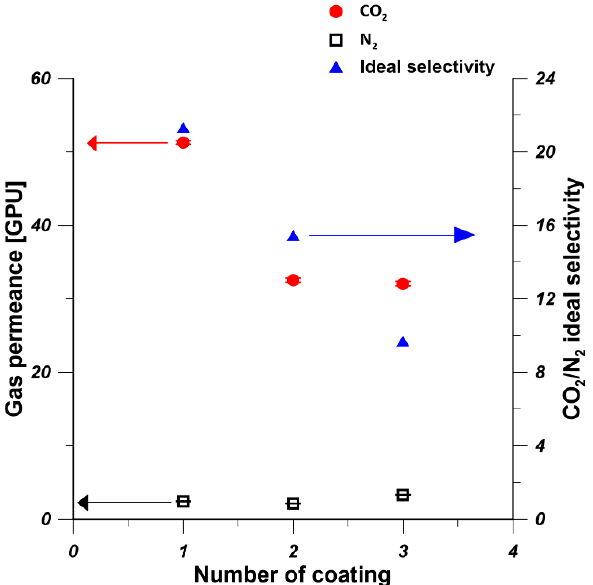
Figure 8. Effect of the number of coating layers on gas permeance and ideal selectivity of PDMS/PEI membranes (PDMS concentration—15 wt% and coating time—10 min).